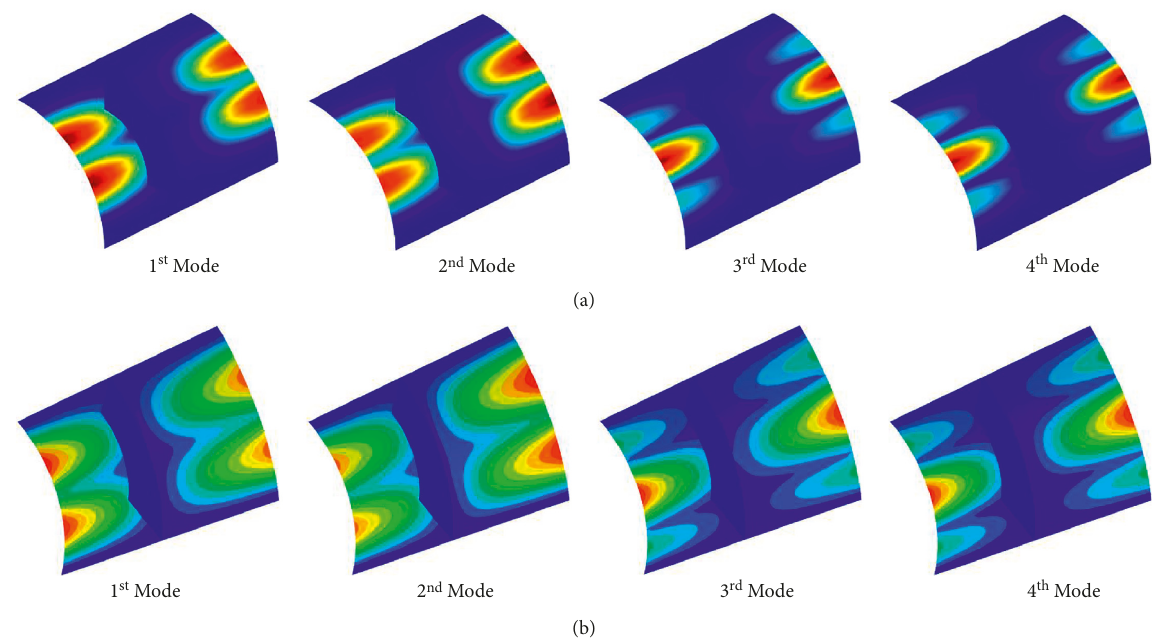
Figure 5: Mode shapes of functionally graded open cylindrical shell with a circumferential bulkhead and FCFC boundary condition ( h � 0.05 m): (a) present and (b) ABAQUS.